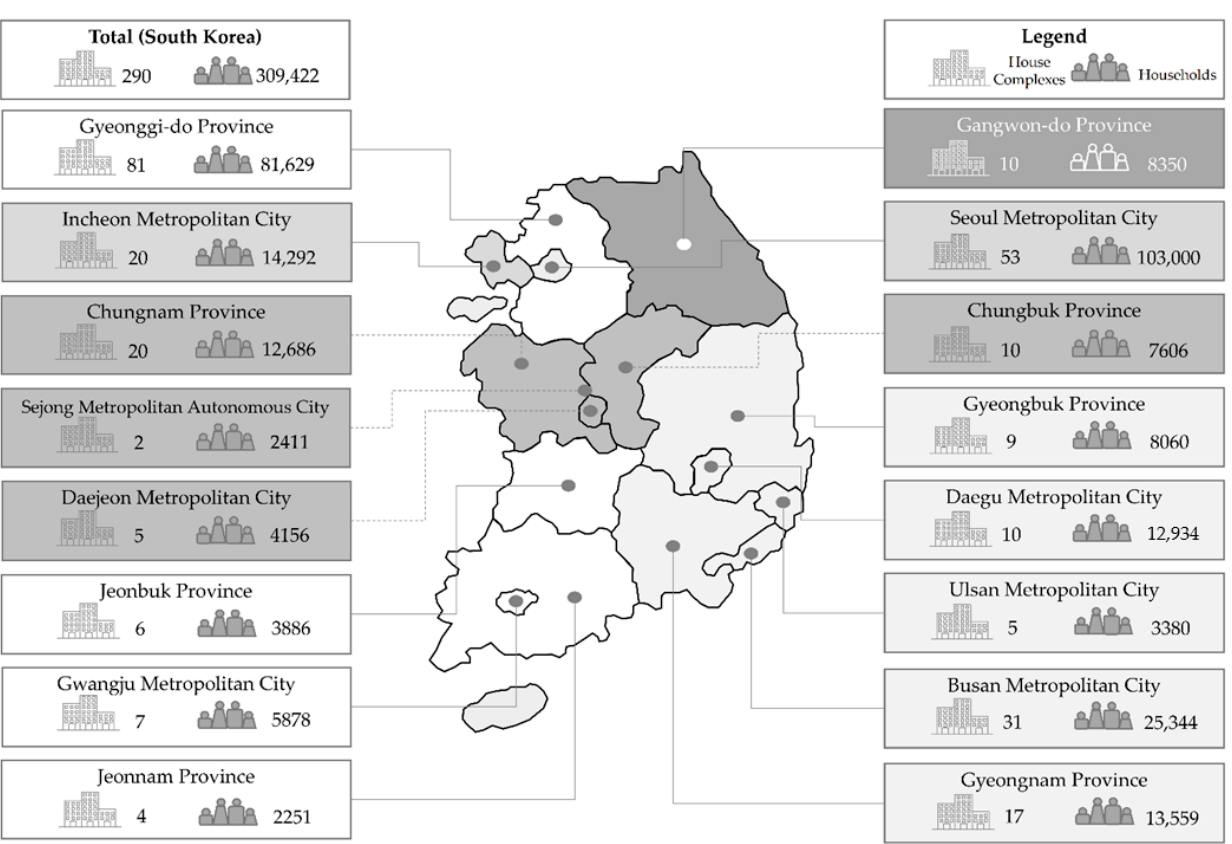
Figure 1. Distribution of study case.